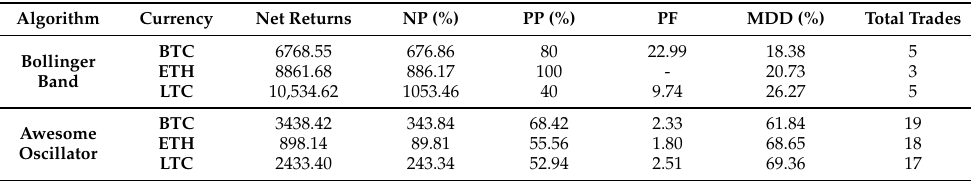
Table 2. Trading results for the combination of neural network and stand-alone models.